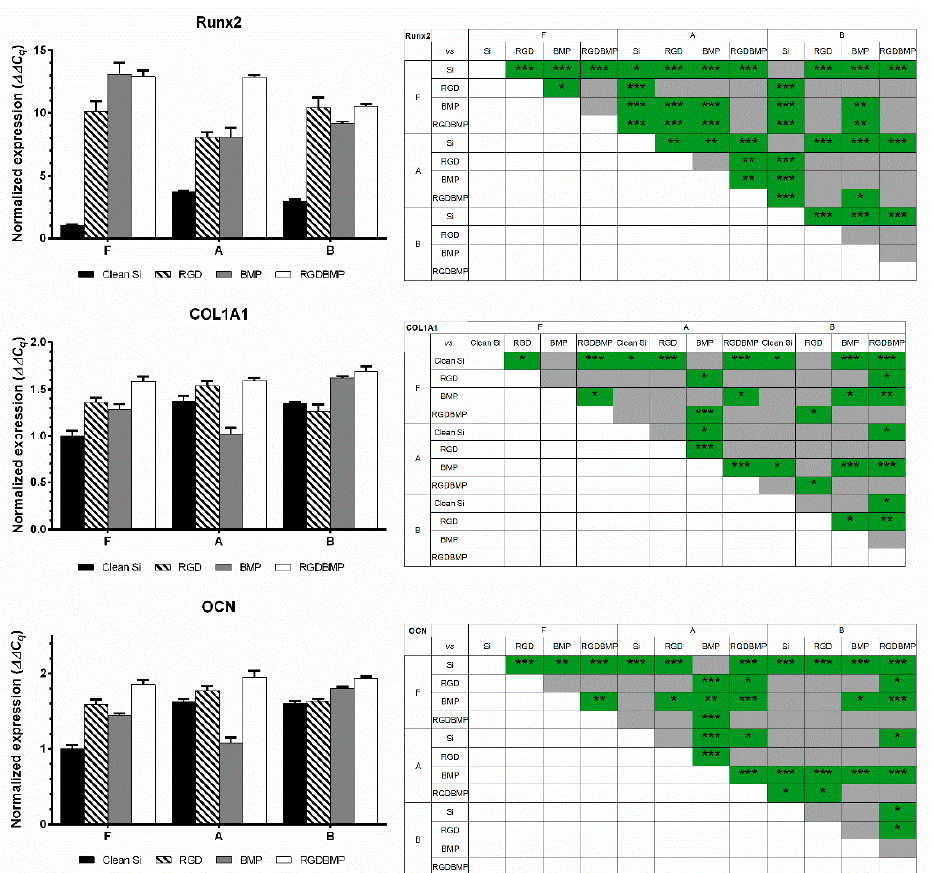
Figure 5. Normalized gene expression from hMSCs cultured for 2 weeks in basal medium, taking non-modified flat silicon as control. Tables summarize significant differences between conditions (grey: non-significant, green: significant differences. * represents p < 0.05, ** p < 0.01, *** p < 0.001).